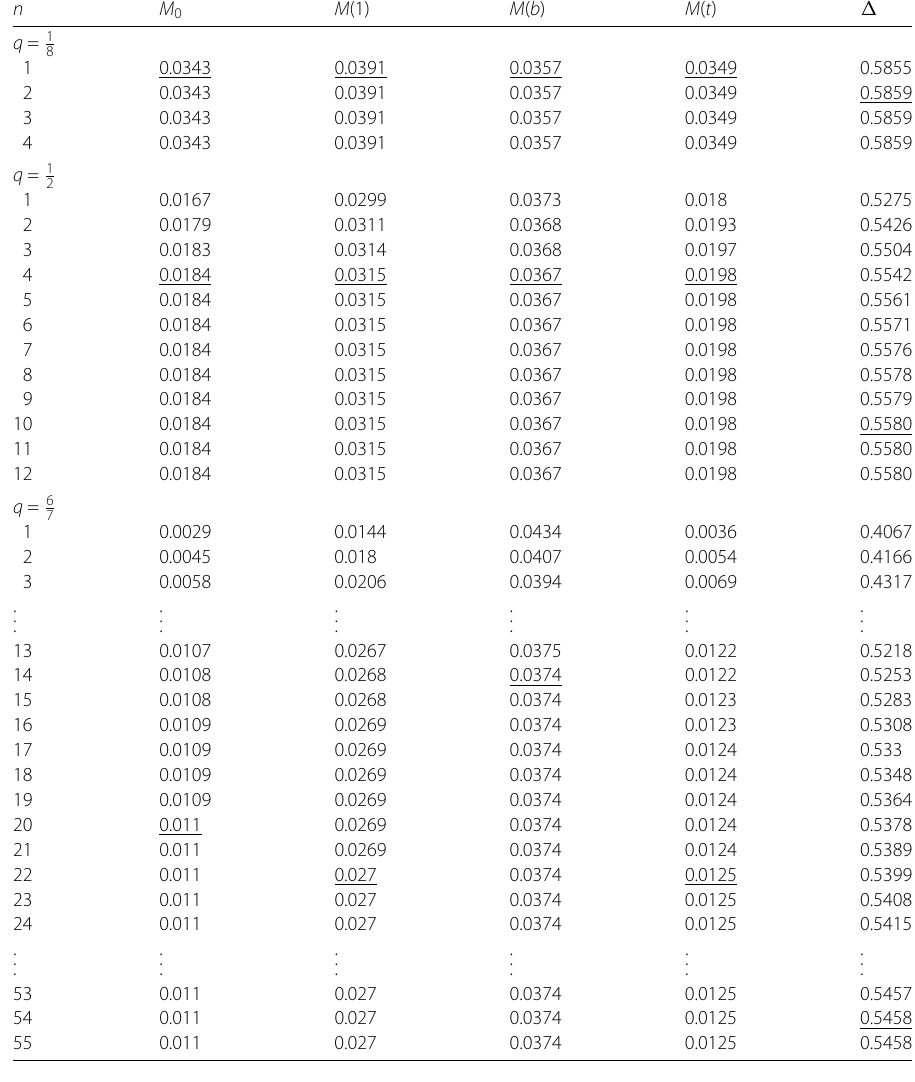
Table 10 Some numerical results for calculation of M 0 , M (1), M ( b ), M ( t ), and (cid:13) < 1 in Example 2 for , 1 , 6 q = 1 8 2